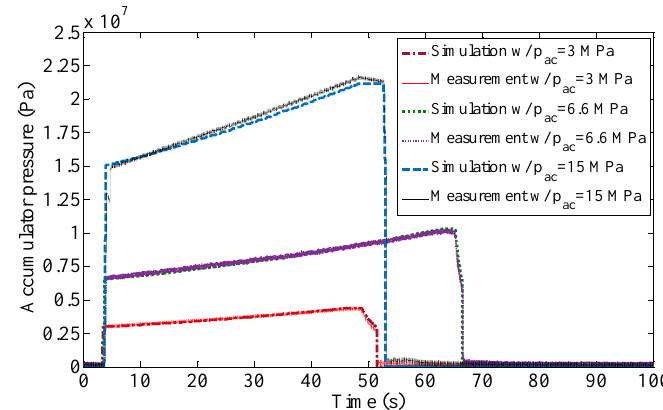
Figure 8. A comparison between the dynamic pressure simulation and the experiment results when the accumulator is pre-charged to 3 MPa, 6.6 MPa, and 15 MPa. Note the simulation takes piston displacement as input and output is the accumulator pressure.